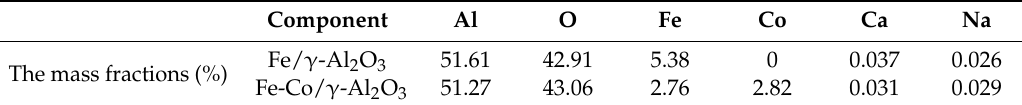
Table 3. Catalyst component.